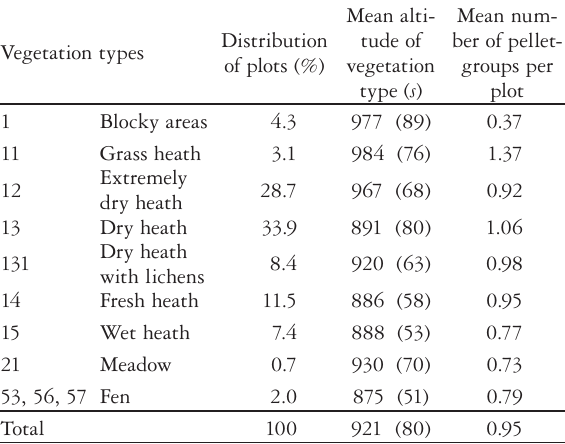
standard deviation s ) of each vegetation type, and mean number of pellet-groups per vegetation